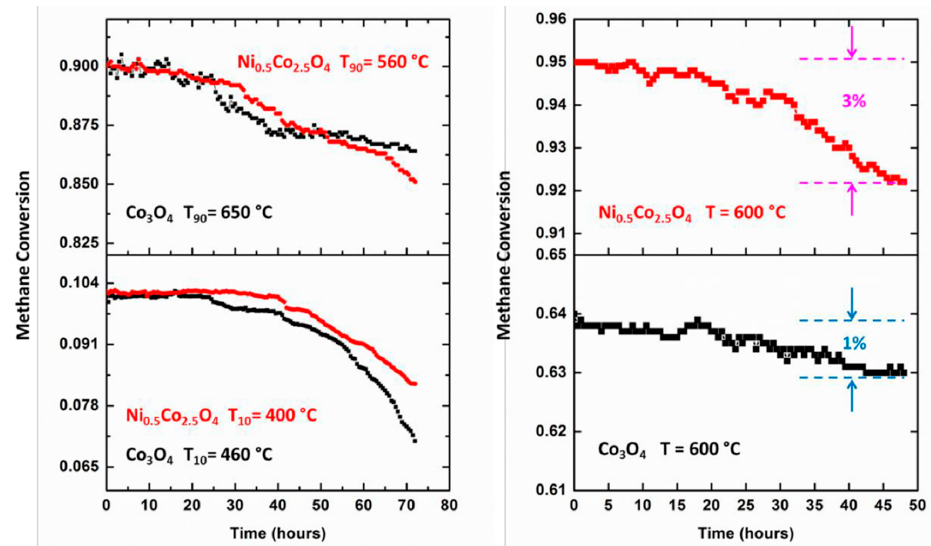
Figure 16. Catalytic stability test results of Ni 0.5 Co 2.5 O 4 and Co 3 O 4 nano ‐ arrays for methane combustion. Reprinted with permission from [17], Copyright Wiley, 2014.